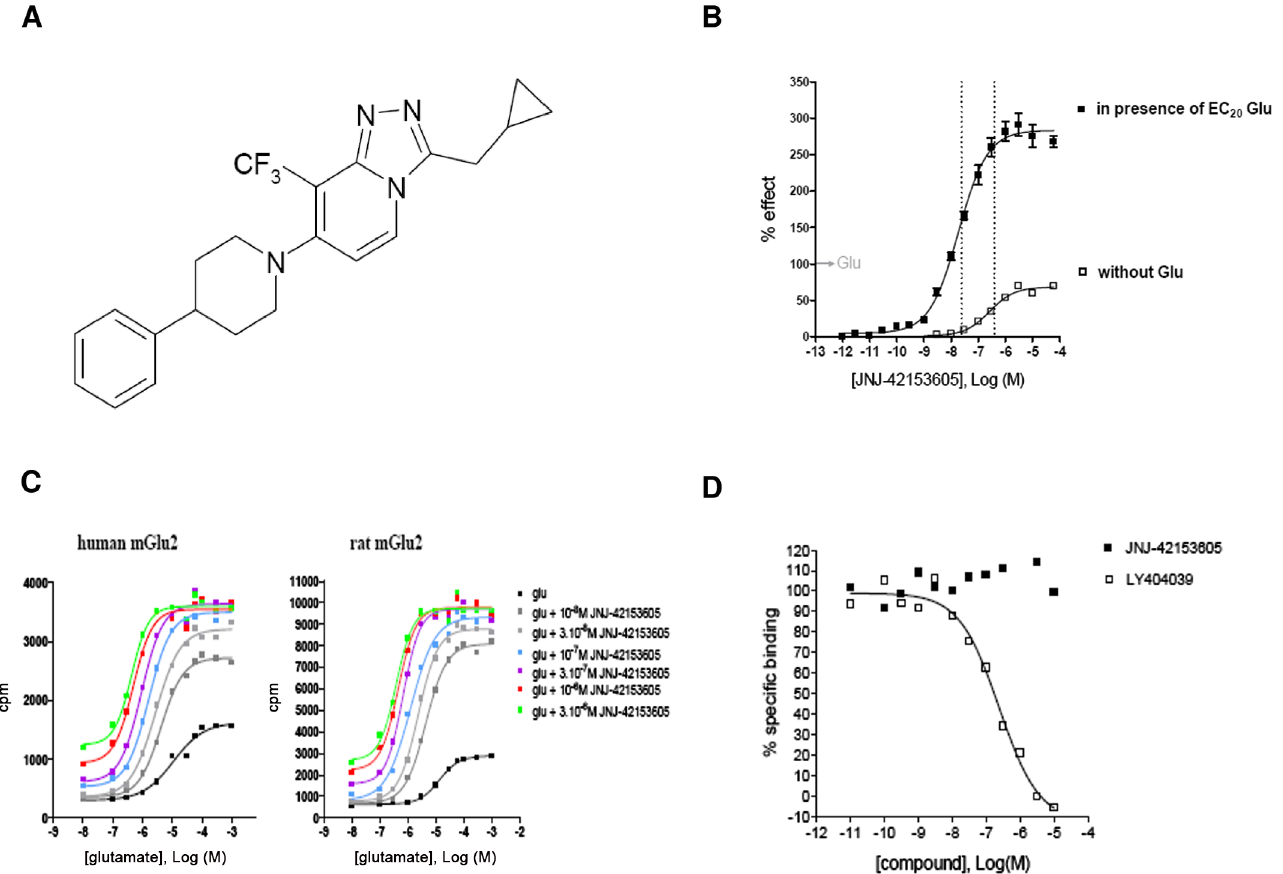
Fig 1. Chemical structure of the mGluR2 PAM JNJ42153605 (A) and in vitro pharmacological characterization thereof in vitro in CHO cells expressing the human and/or rat mGluR2 (B, C, D). Fig 1B shows the [ 35 S]GTP γ S concentration-response curve of JNJ-42153605 in the absence or presence of an EC 20 glutamate concentration. Data are expressed as percentage of the maximal response to glutamate and are mean ± S.E.M. of 9 – 10 experiments. Fig 1C represents glutamate-induced [ 35 S]GTP γ S binding in the absence or presence of increasing concentrations of JNJ-42153605. JNJ- 42153605 shifts the glutamate concentration-response curve to the left in CHO cells expressing the human (left panel) or rat (right panel) mGluR2. Data for the human mGluR2 were repeated 3 times with similar results. Fig 1D shows [ 3 H]LY341495 binding to the human mGluR2 in the presence of either LY404039 or JNJ-42153605. LY404039 but not JNJ-42153605 displaces [ 3 H]LY341495 from the orthosteric agonist (glutamate) binding